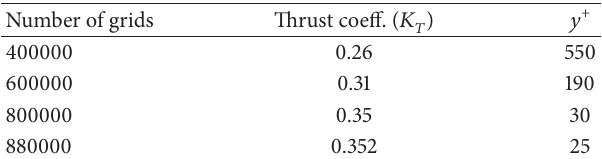
Table 1: Grid number, thrust coefficient, and its 𝑦 + values ( 𝑃/𝐷 = 0.8